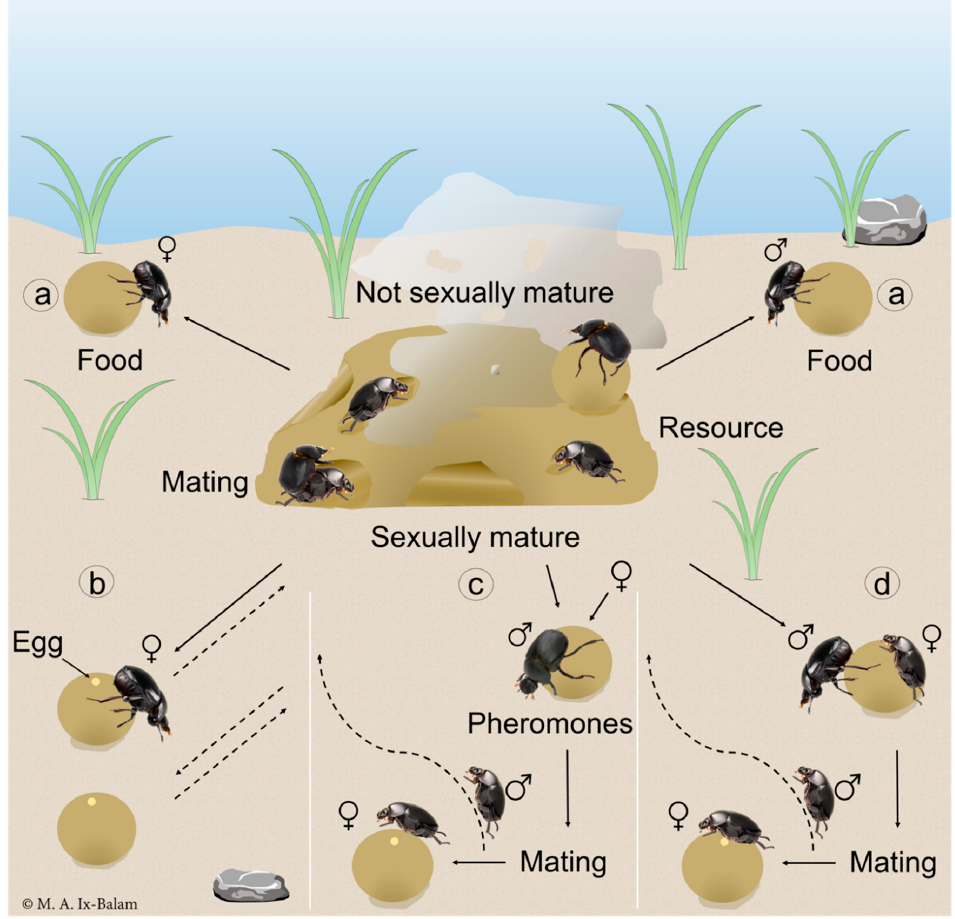
Figure 4. Possible scenarios for mating and resource exploitation by both male and female Deltochilum furcatum that would explain why both sexes mark food balls.